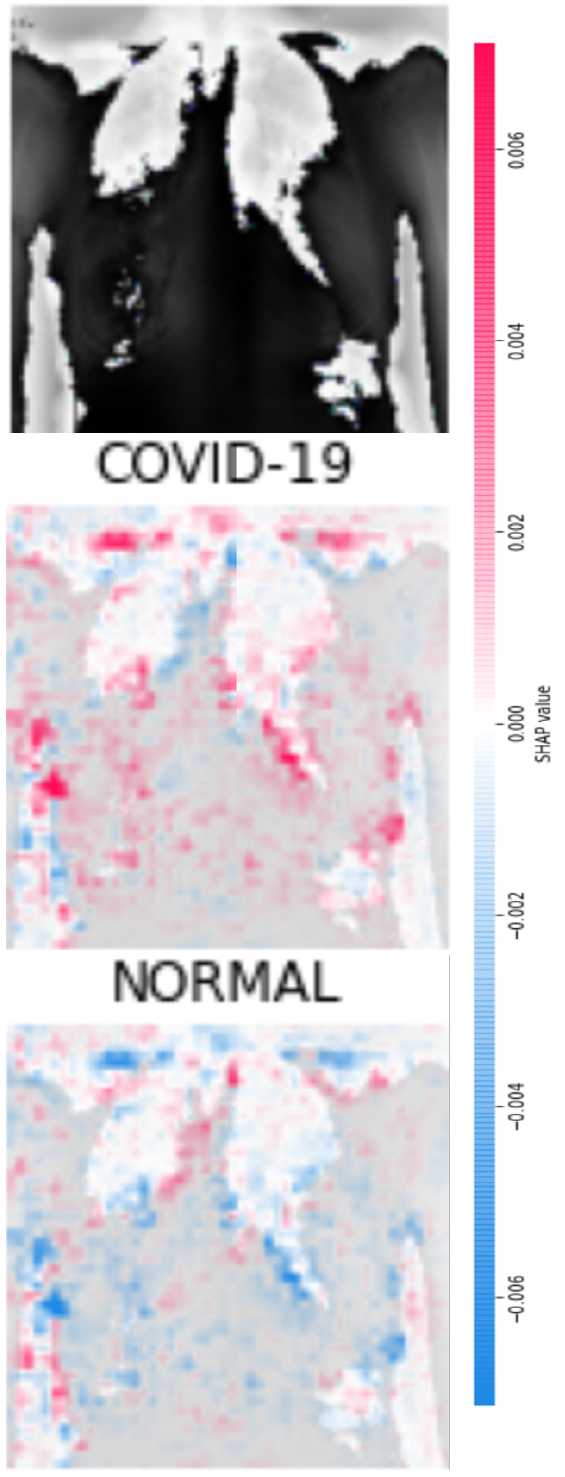
Figure 11. SHAP scores for the image displayed in Figure 8